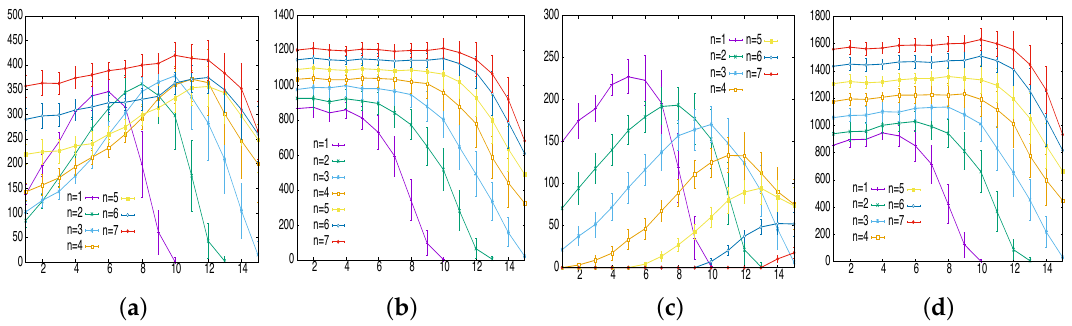
Figure 4. Simulation results in online markets with penalized DA mechanism. ( a ) Buyers’ surplus; ( b ) Buyers’ resale profit; ( c ) Buyers’ penalty; ( d ) Buyers’